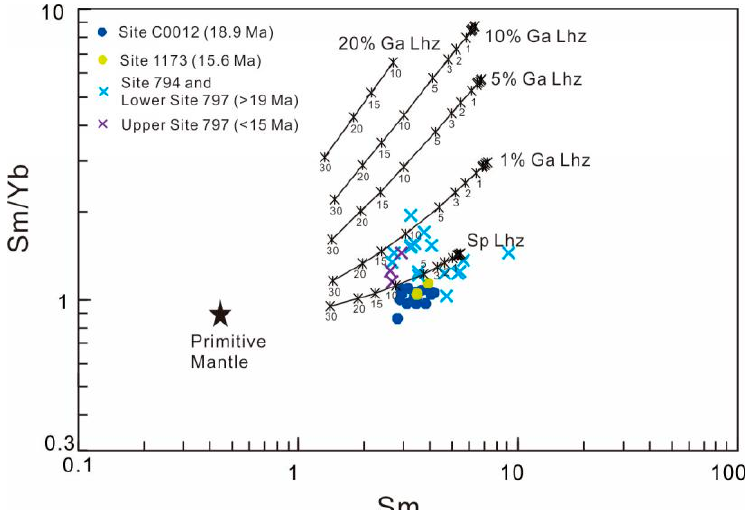
Figure 13. Plots of Sm/Yb versus Sm for Cenozoic volcanic rocks of the Site C0012 and Site 1173 in the Shikoku Basin. Data sources as for Figure 6. The data for the primitive mantle are from Reference [56]. The compositions of spinel lherzolite (Sp Lhz), 1, 5, 10, and 20% garnet lherzolite (Ga Lhz) are Ol 0.59 + Opx 0.05 + Cpx 0.16 + Sp 0.20 , Ol 0.69 + Opx 0.20 + Cpx 0.10 + Gt 0.01 , Ol 0.65 + Opx 0.20 + Cpx 0.10 + Gt 0.05